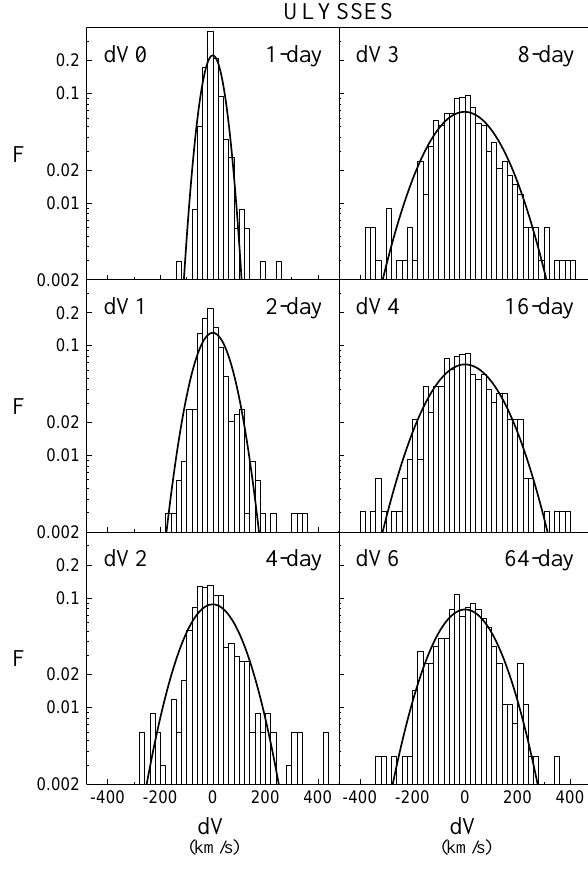
Fig. 4. The occurrence frequency F (in a logarithmic scale) of the Ulysses velocity differences dV 0, dV 1, dV 2, dV 3, dV 4, and dV 6 is shown by histograms in the different panels. The solid curves give Gaussian distributions as computed from the observed values of mean and standard